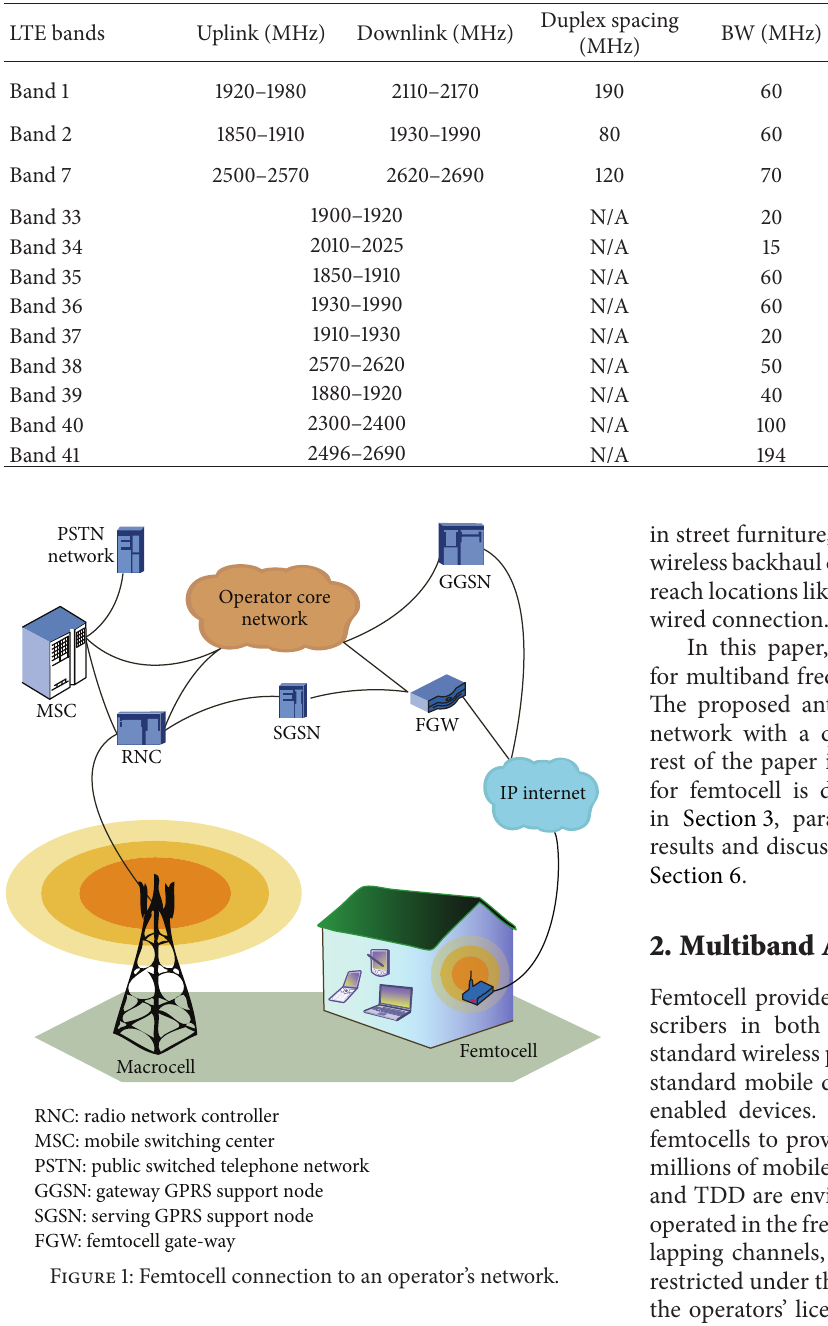
Table 1: LTE frequency bands and corresponding regions.